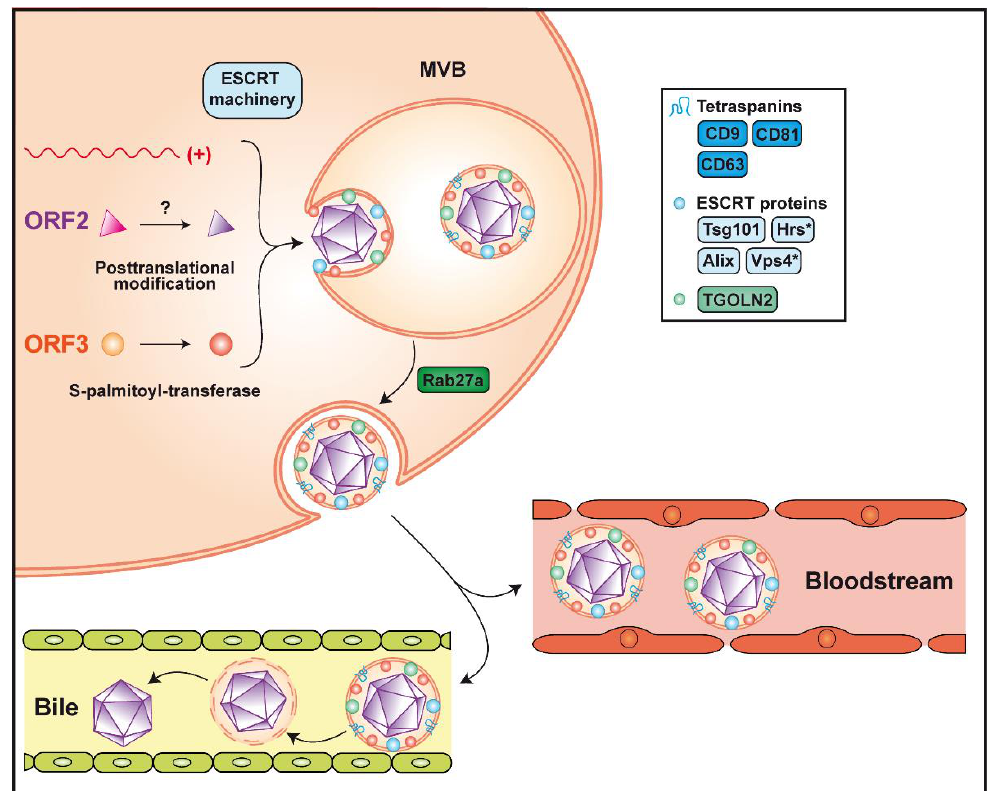
Figure 3. Assembly and release of infectious hepatitis E virus. Packaging of the viral genome into the capsid is believed to occur by spontaneous self-assembly of the non-glycosylated ORF2 protein. The non-glycosylated ORF2 protein may undergo post-translational modification by yet unknown enzyme(s). Formation of the quasi-enveloped particle involves phosphorylation and palmitoylation of the ORF3 protein and the ESCRT machinery, of which the components Tsg101, Hrs, Vps4 and Alix were shown to be required (see text for abbreviations). The virion is wrapped in an exosomal membrane harboring the tetraspanins CD9, CD63 and CD81, as well as the trans-Golgi network protein 2 (TGOLN2), Alix and Tsg101. Release of quasi-enveloped HEV (eHEV) involves Rab27a-dependent trafficking of multivesicular bodies (MVB) and fusion with the plasma membrane. Secreted particles remain associated with the lipid membrane in the bloodstream while they are delipidated in the bile. Asterisks indicate host factors that were not found on the quasi-envelope of